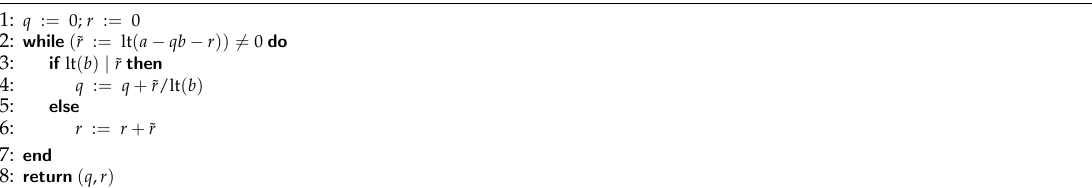
Algorithm 3 DIVIDE P OLYNOMIALS ( a , b ) a , b ∈ K [ x 1 ,..., x v ] , b (cid:54) = 0; return q , r ∈ K [ x 1 ,..., x v ] such that a = qb + r where r = 0 or lt ( b ) does not divide any term in r ( r is reduced with respect to the Gröbner basis { b }